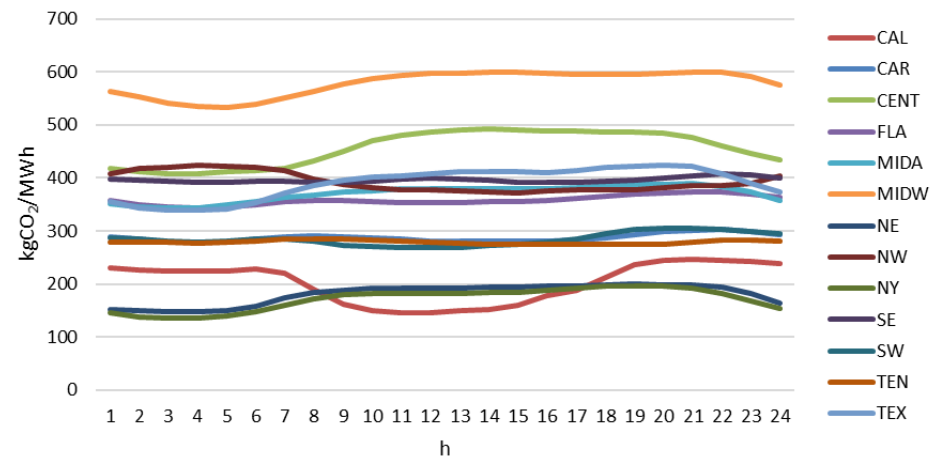
Figure 6. Specific GHG emissions profiles in each region.